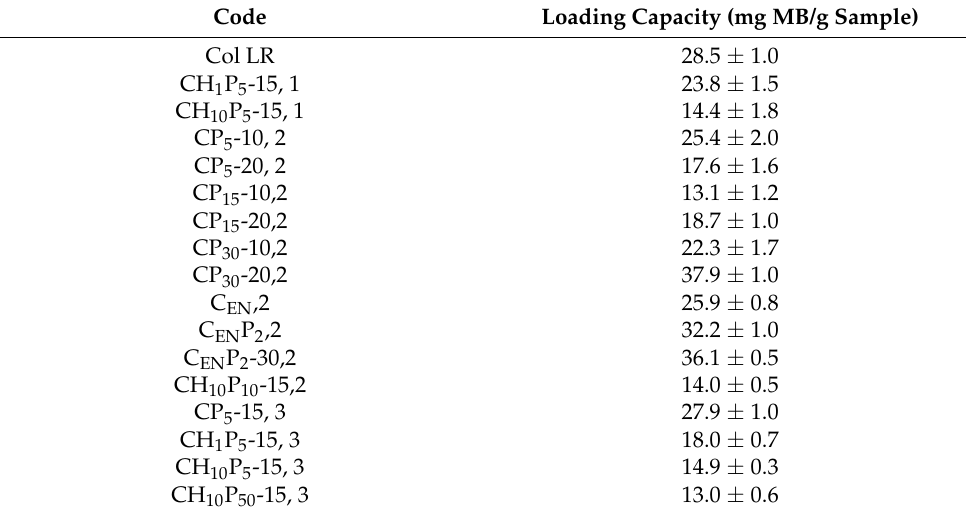
Table 2. Spectrophotometrical data on MB loading in collagen-based samples.